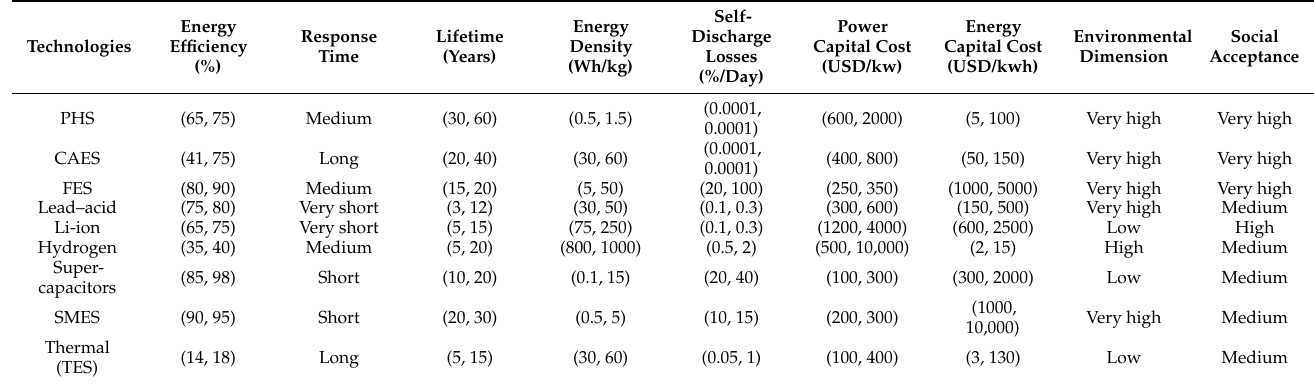
Table A5. Decision basic data of Expert 4.